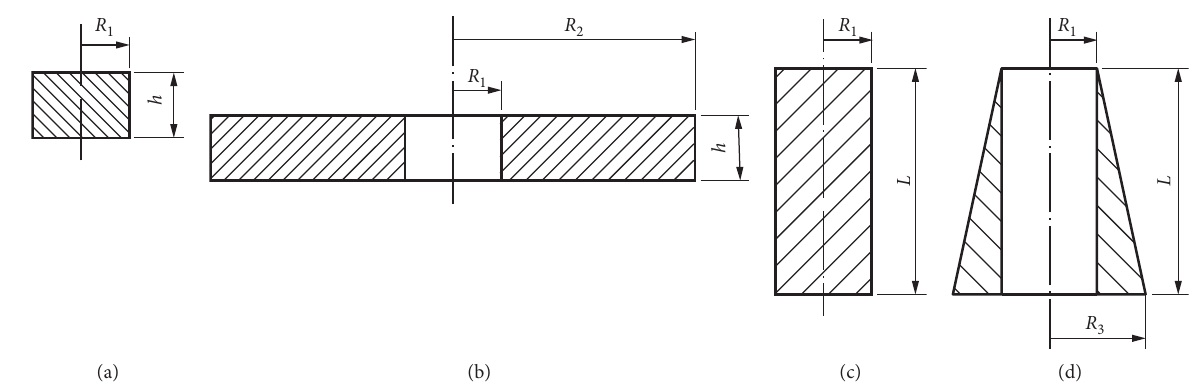
Figure 2: (a) The first part Ω 1 . (b) The second part Ω 2 . (c) The third part Ω 3 . (d) The fourth part Ω 4 .